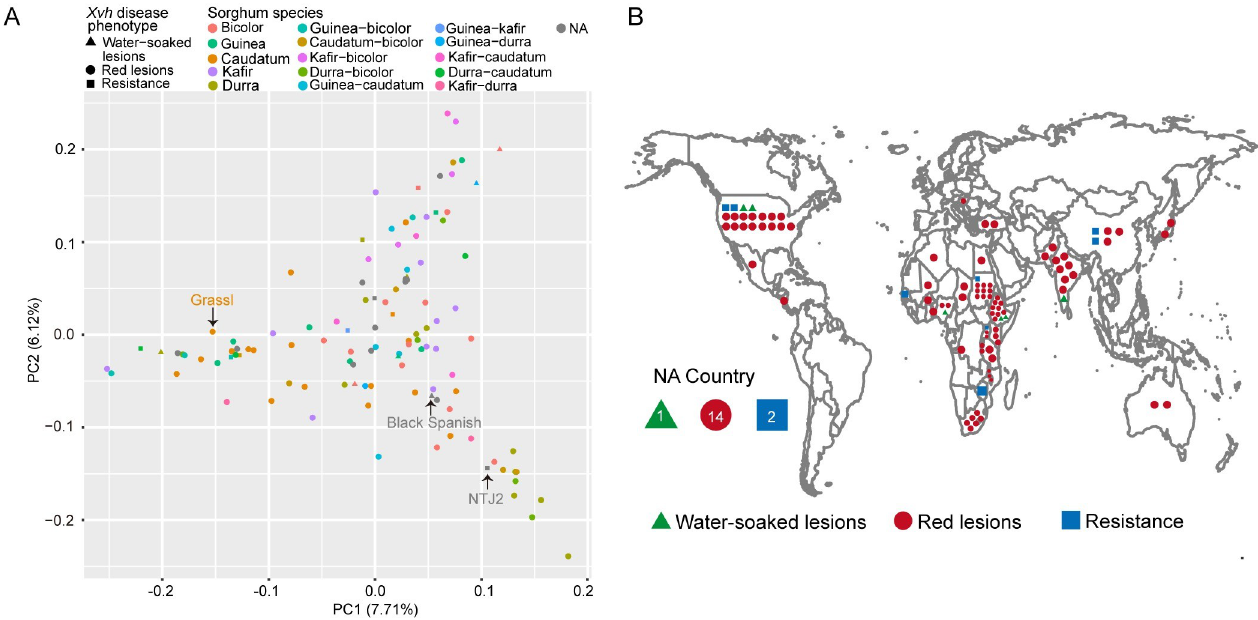
Fig 3. Xvh -disease phenotypes are distributed across 113 sorghum genotypes from diverse geographical origins. (A) Principal component analysis (PCA) of sorghum genotypes with GBS-based SNPs. Sorghum genotypes are colored based on race, and the respective disease phenotypes are indicated by symbol shape. The three Xvh -disease phenotypes do not cluster by PC1 or PC2. (B) Geographical distribution of sorghum genotypes. The three Xvh -disease phenotypes are widely distributed around the world. Black Spanish (water-soaked lesions), Grassl (red lesions), and NTJ2 (resistance).